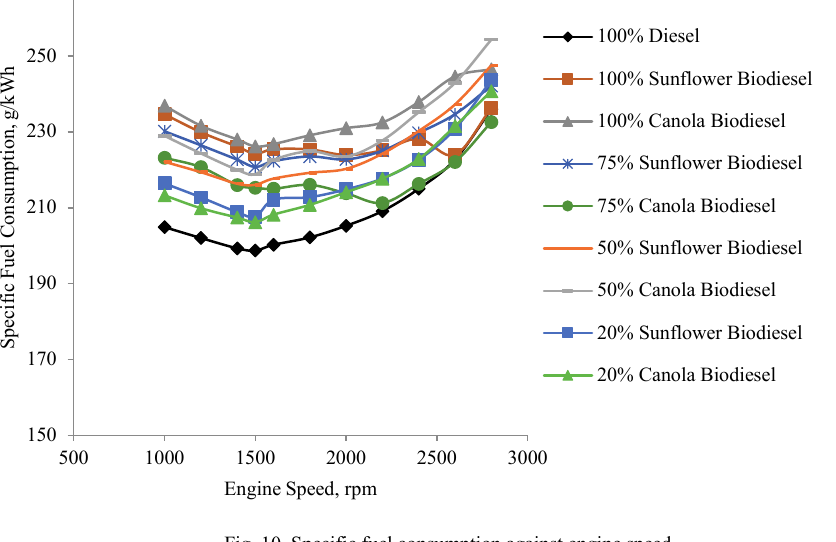
Fig. 10. Specific fuel consumption against engine speed.